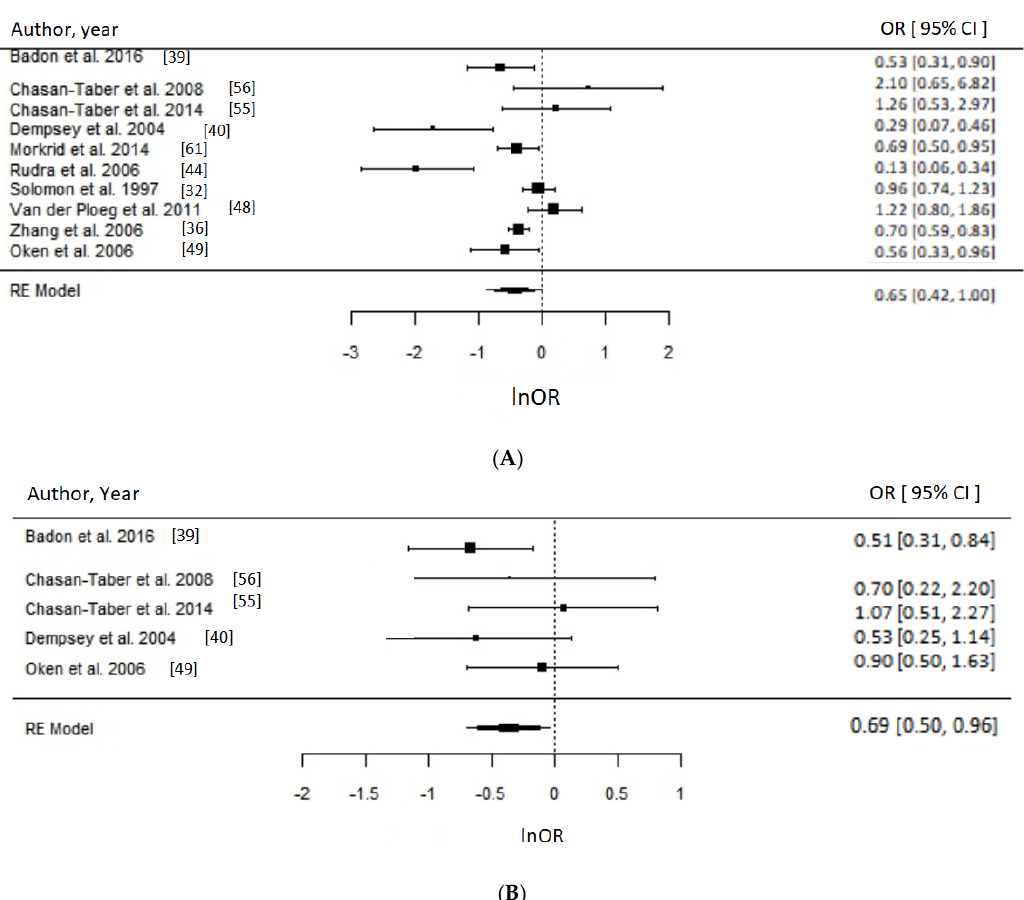
Figure 4. Metaanalysis of participation in high versus low level of leisure time physical activity (LTPA) and odds of gestational diabetes (GDM). Estimates are expressed as odds ratios (OR) with their corresponding 95% confidence intervals, however x -axis uses lnOR scale. ( A ) Engaging in any LTPA before pregnancy suggested possible reduced odds of GDM (OR = 0.65, 95% CI = 0.43–1.00; I 2 = 90% (high), p -value = 0.05); ( B ) Engaging in any LTPA during early pregnancy suggests reduced odds of GDM (OR = 0.69, 95% CI = 0.50–0.96; I 2 = 15% (low), p -value = 0.03).